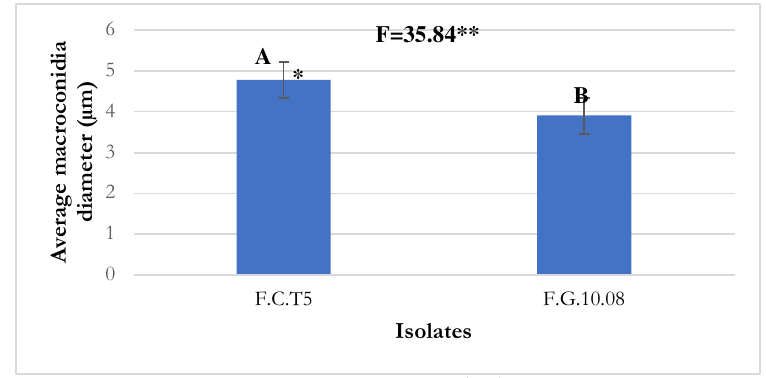
FigureFigureFigureFigure 7. 7. 7. 7. Average macroconidia diameter of the two isolates (µm)